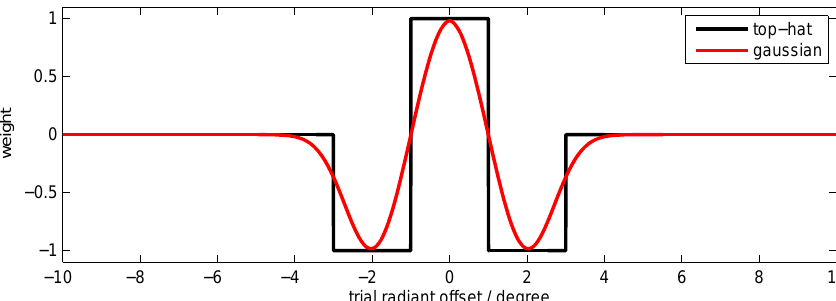
Fig. 1. Comparison of two three band radiant weighting functions.